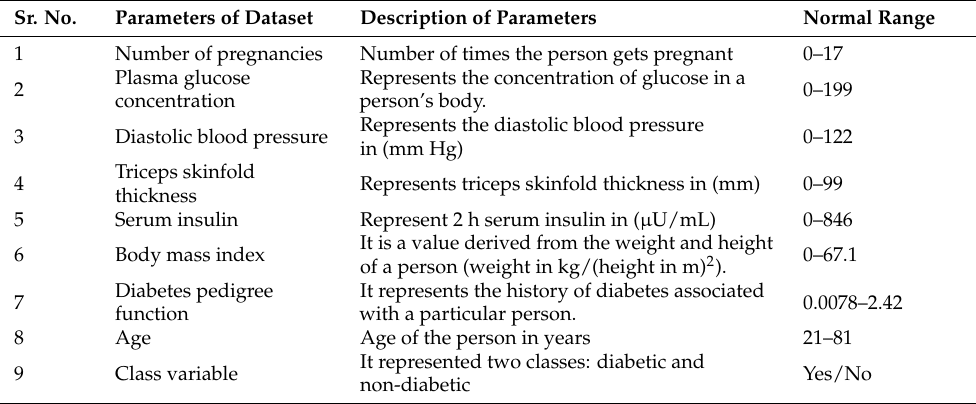
Table 3. Description of the dataset attributes.